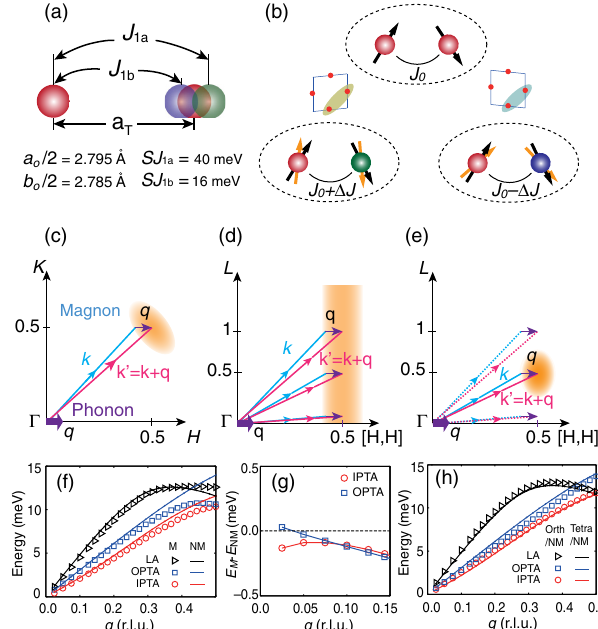
FIG. 5. (a) Schematics of the nearest-neighbor Fe ‐ Fe bond. The small difference between a o = 2 and b o = 2 and the large difference between J 1 a and J 1 b render a non-negligible Δ J= Δ r , which entangles the lattice and magnetism. (b) One pair of magnetic Fe ions in the paramagnetic tetragonal phase with the magnetic binding energy of E b ¼ J 0 S 1 S 2 cos θ . As the Fe-Fe bond stretches, the spin exchange coupling increases; thus, there is an energy transfer from the lattice to the spin system. (c) The scattering triangle required by the momentum conservation in the dynamic spin-lattice coupling process within the ½ H; K (cid:2) plane. (d,e) The momentum triangles in the ½ H; H; L (cid:2) plane above and below T s . As spin fluctuations undergo a 2D-to-3D transition, a large part of the spin-lattice-coupling scattering channel would be blocked. (f) Comparison of the phonon dispersions obtained from DFT calculations with (markers, M ) and without (solid lines, NM ) magnetism, assuming a tetragonal lattice. We note that the nonmagnetic tetragonal phase does not really exist in NaFeAs since spin correlations are strong at temperatures far above T N and T s . (g) Wave-vector dependence of E M − E NM for IPTA and OPTA phonon modes. (h) Comparison of the phonon dispersions obtained from DFT calculations with a nonmagnetic ( NM ) Fe site assuming orthorhombic (markers) and tetragonal (solid lines) lattices. The black, blue, and red colors represent LA, OPTA, and IPTA phonon